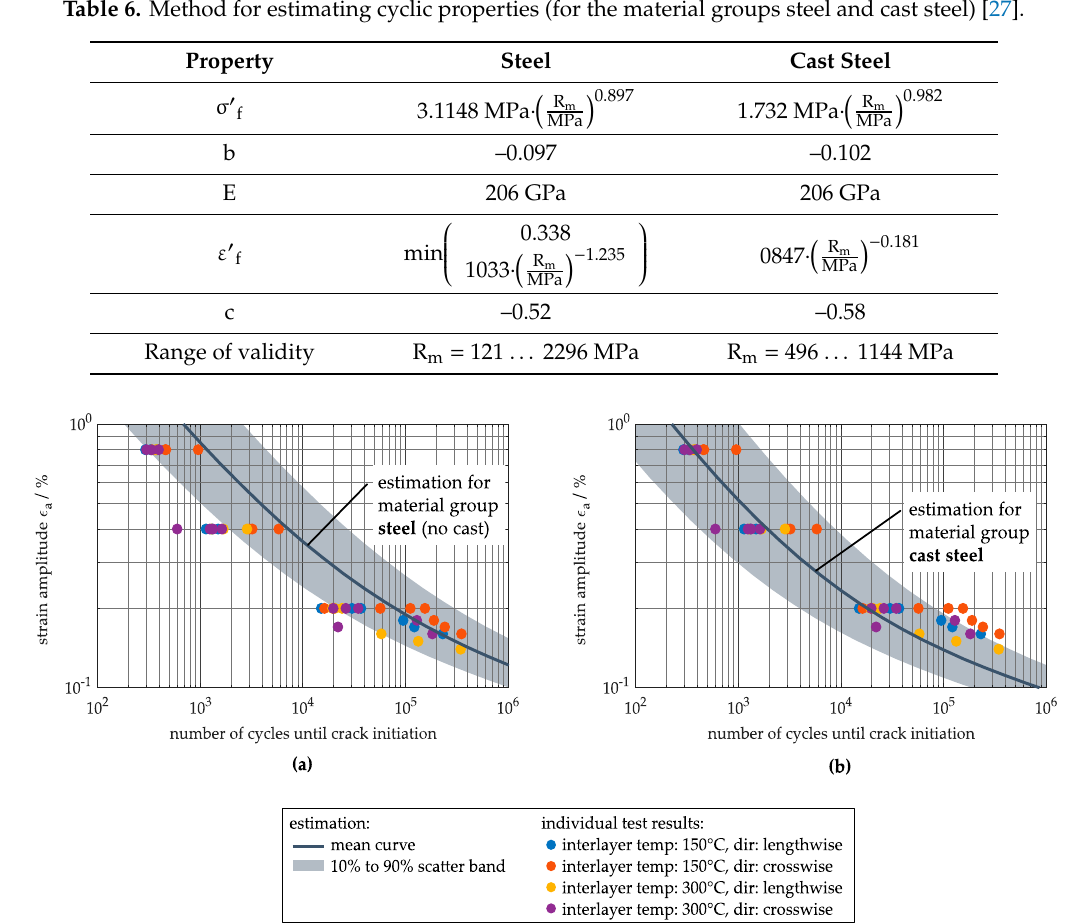
Figure 14. Estimated strain–life curves for steel ( a ) and cast steel ( b ) for R m = 538 MPa and individual test results from Figure 12.